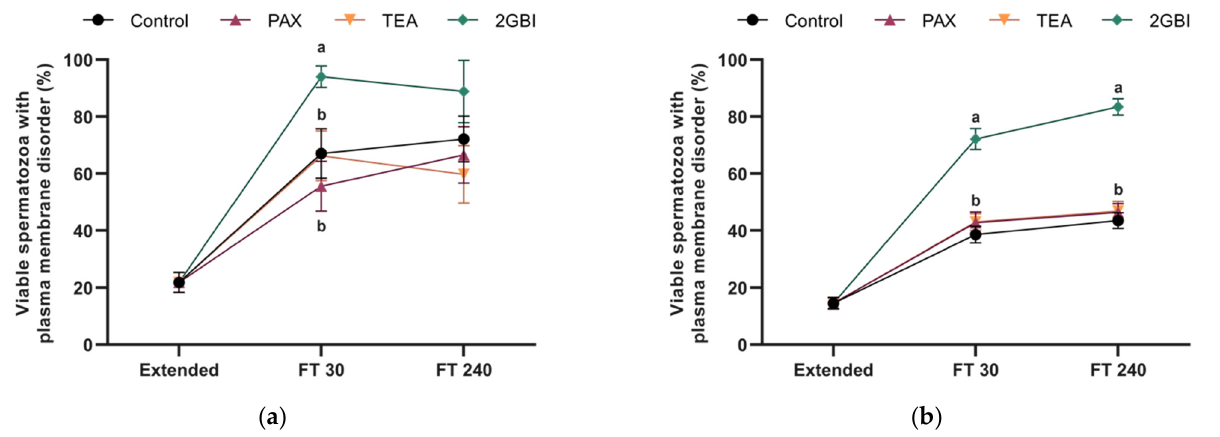
Figure 5. Percentages of viable spermatozoa with high membrane lipid disorder in extended and frozen–thawed (FT) samples at 30 min and 240 min post-thaw. In Experiment 1 ( n = 8), TEA, PAX, and 2-GBI blockers were added to LEY medium at 15 ◦ C ( a ), whereas in Experiment 2 ( n = 9), they were added to LEYGO medium at 5 ◦ C ( b ). Different superscripts indicate significant differences ( P < 0.05) between samples within the same time point. Results are given as mean ± SEM.